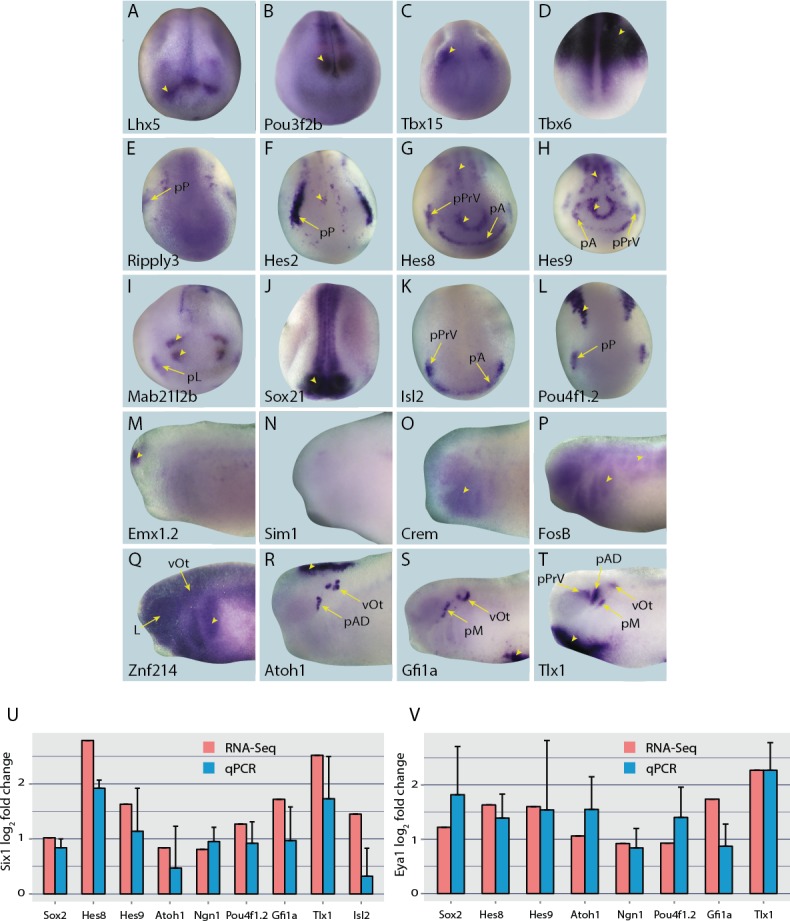
Expression of selected presumptive direct targets of Six1/Eya1 in whole-mount Xenopus embryos.Genes expressed at neural plate stages (stages 14–18) are shown in panels A–L, and those only expressed at later stages are shown at mid/late tail bud stage (stages 28–32) in panels M–T. Several of the genes surveyed (Lhx5, Pou3f2b, Tbx15, Tbx6, Emx1.2 and Sim1 (A–D, M and N), were not expressed in the PPE, nor any placodal derivatives in later stages. Instead, such genes were expressed in the adjacent neural folds (Lhx5, Pou3f2b and Tbx15), ectoderm (Tbx6), or in the forebrain at later stages (Emx1.2). Several other genes were expressed broadly across the cranial ectoderm, at least partially overlapping with the PPE at neural plate stages (Ripply3, Crem, FosB and Znf214; E,O–Q), some of which are also maintained in placodal derivatives such as Znf214 in the otic vesicle (Q). The remaining genes (F–L, R–T) are expressed in parts of the PPE and maintained in some placodes (Hes2, Hes8, Hes9, Mab21l2b, Sox21, Isl2, Pou4f1.2, and Tlx1) or are expressed in a subset of placodes only (Atoh1, Gfi1a) (see Figure 4—figure supplements 1–4 for additional stages). Yellow arrows mark placodal expression. Arrowheads mark non-placodal expression. Abbreviations: pA: anterior placodal region; pAD: anterior lateral line placode; pE: epibranchial placode; pL: lens placode; L: lens; pM: middle lateral line placode; pO: olfactory placode; pP: posterior placodal region; pPrV: profundal/trigenimal placodes; vOt: otic vesicle. Plots U and V show qPCR after Six1 or Eya1 overexpression. Log2 fold change values were calculated from qPCR data obtained after overexpression of Six1-GR (U) or Eya1-GR (V) in placodal explants and are shown next to corresponding fold change values obtained from the RNA-Seq data. In all cases shown, qPCR values broadly corroborate those from the RNA-Seq data - showing up-regulation of target genes after either Six1 or Eya1 overexpression. Vertical error bars show the standard deviation of the mean of biological triplicates.